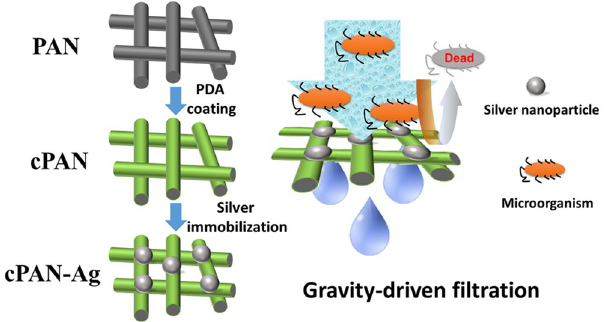
Figure 1. Schematic diagram of preparation and application of the silver-loaded nanofibrous